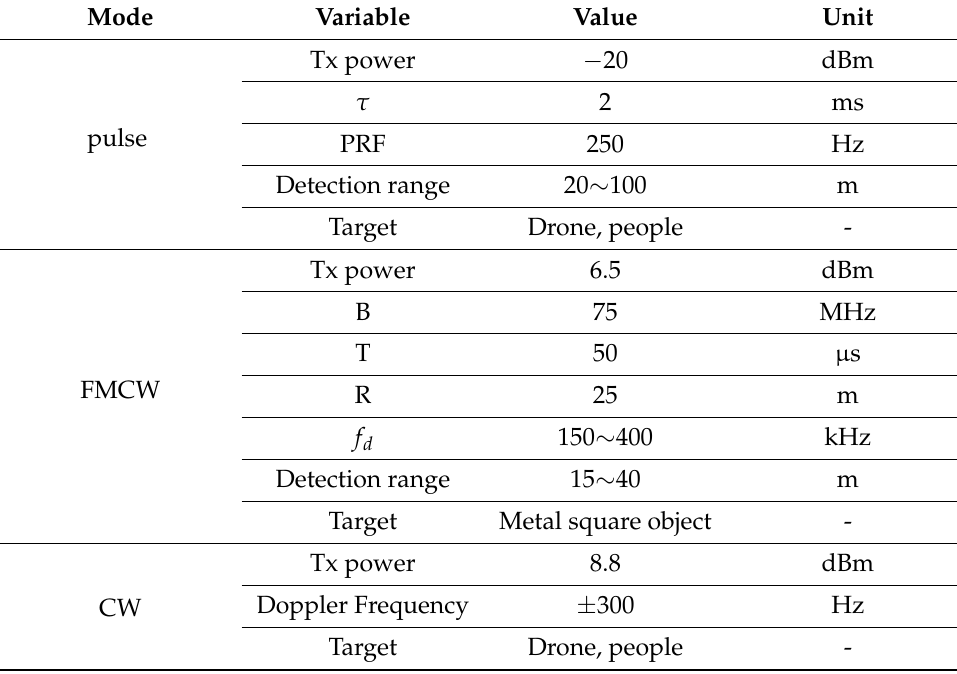
Table 6. Summary of the radar